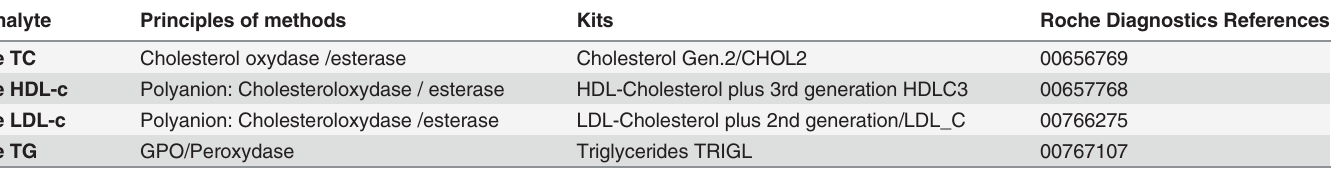
Table 1. References of reagent kits used and their assay principle. Analyte